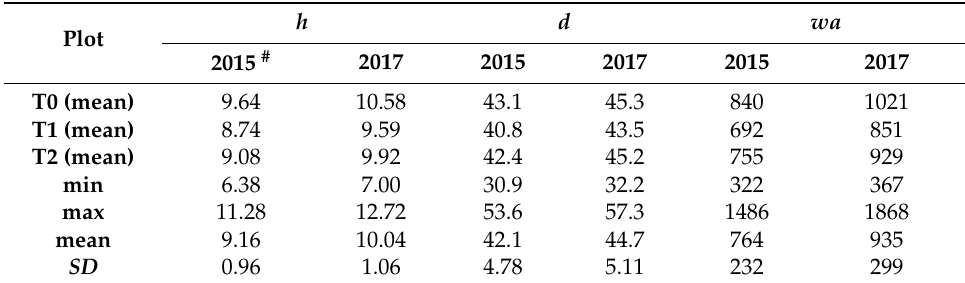
Table 1. Field data for 50 trees within 3 field plots.